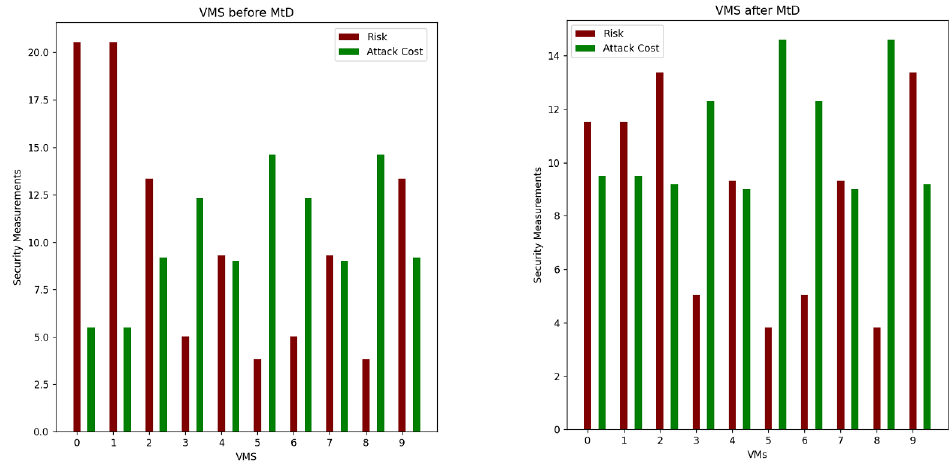
Figure 7. Comparison of security metrics of VMs before and after applying shuffle and diversity